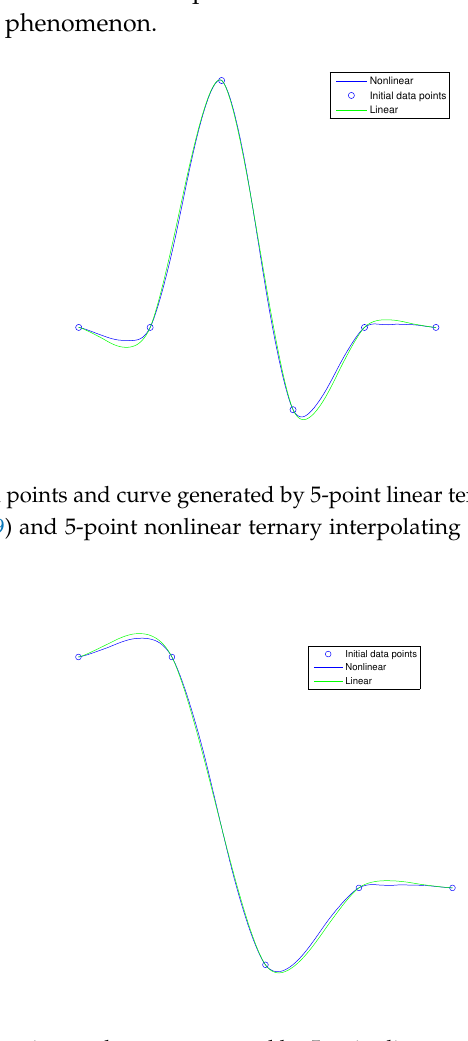
Figure 2. Initial control points and curve generated by 5-point linear ternary interpolating subdivison scheme (5th level) in (9) and 5-point nonlinear ternary interpolating subdivision scheme (11) with w =